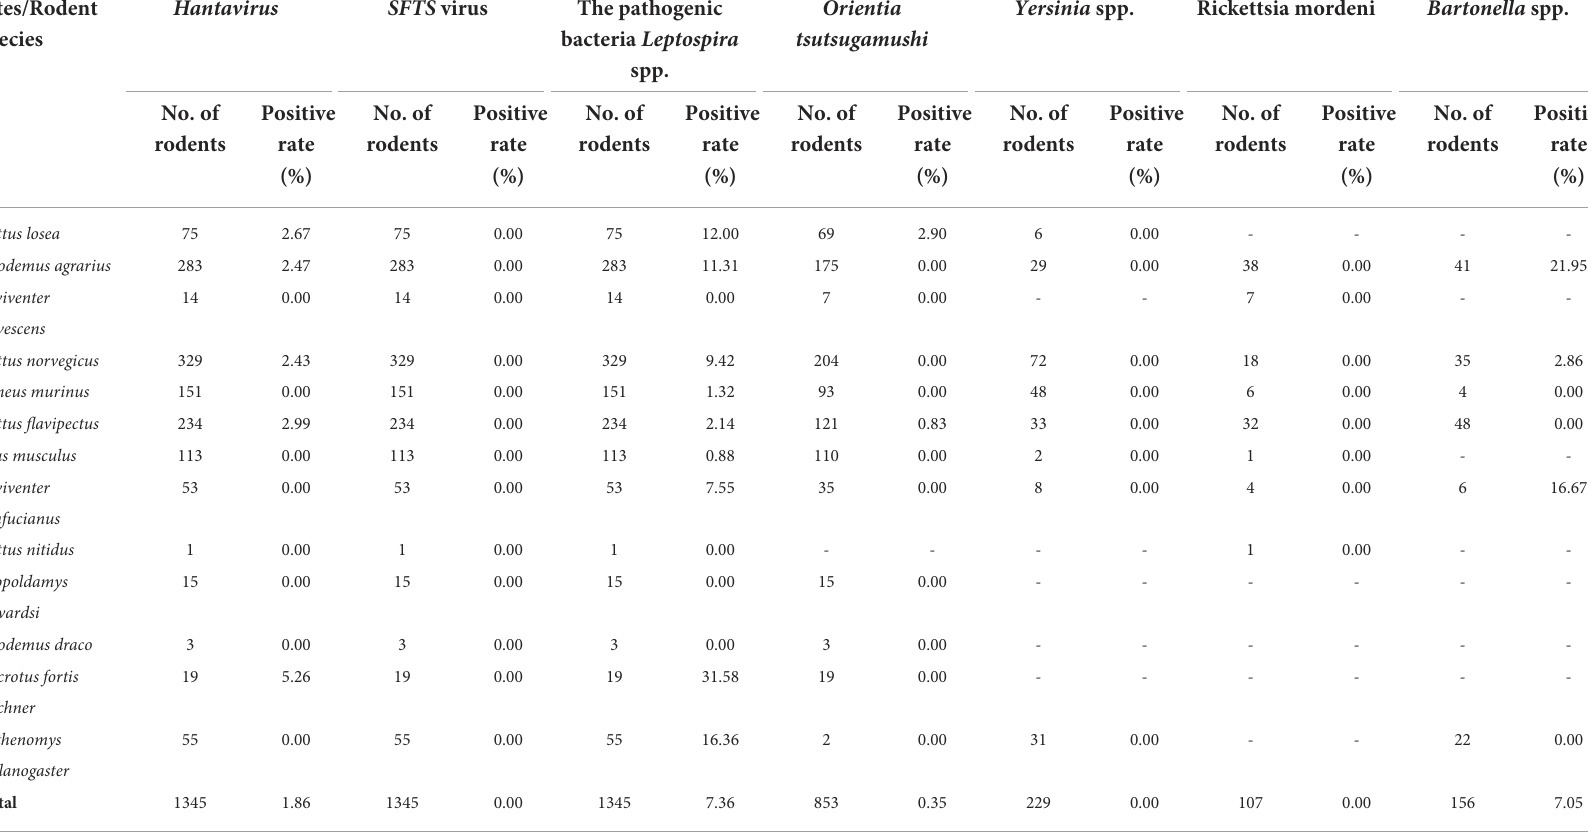
TABLE 4 The prevalence of pathogen infections in different rodent species in Zhejiang Province, 2020.